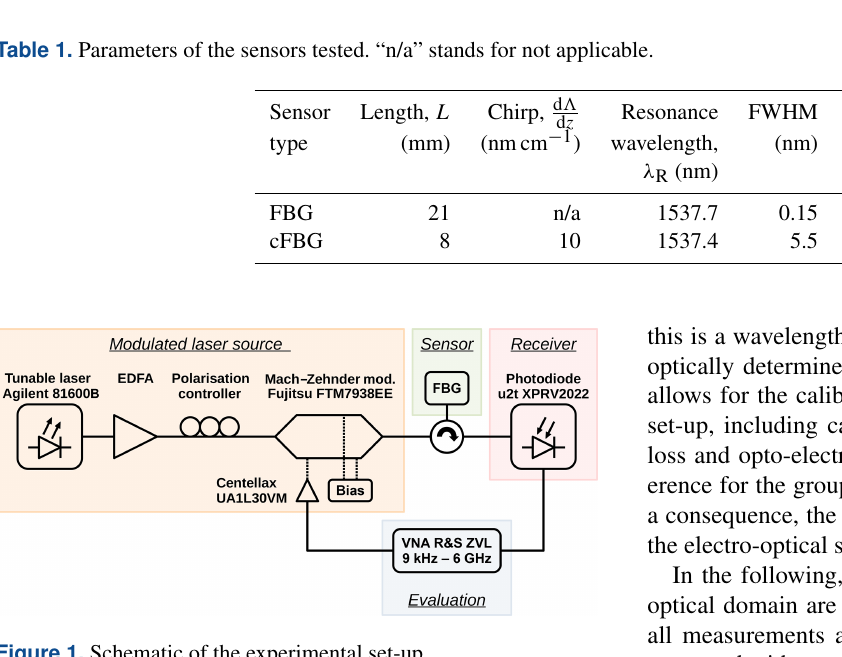
Figure 1. Schematic of the experimental